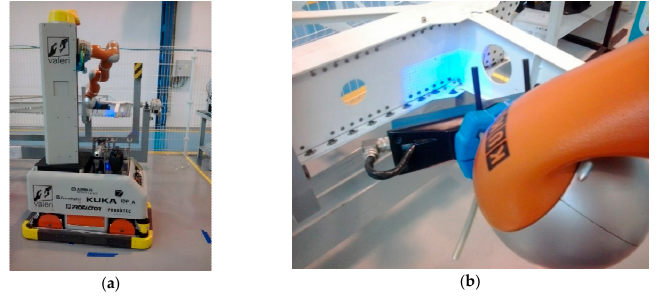
Figure 17. Mobile robot using a blue light sensor for part localization. ( a ) Mobile robot; ( b ) Sensor